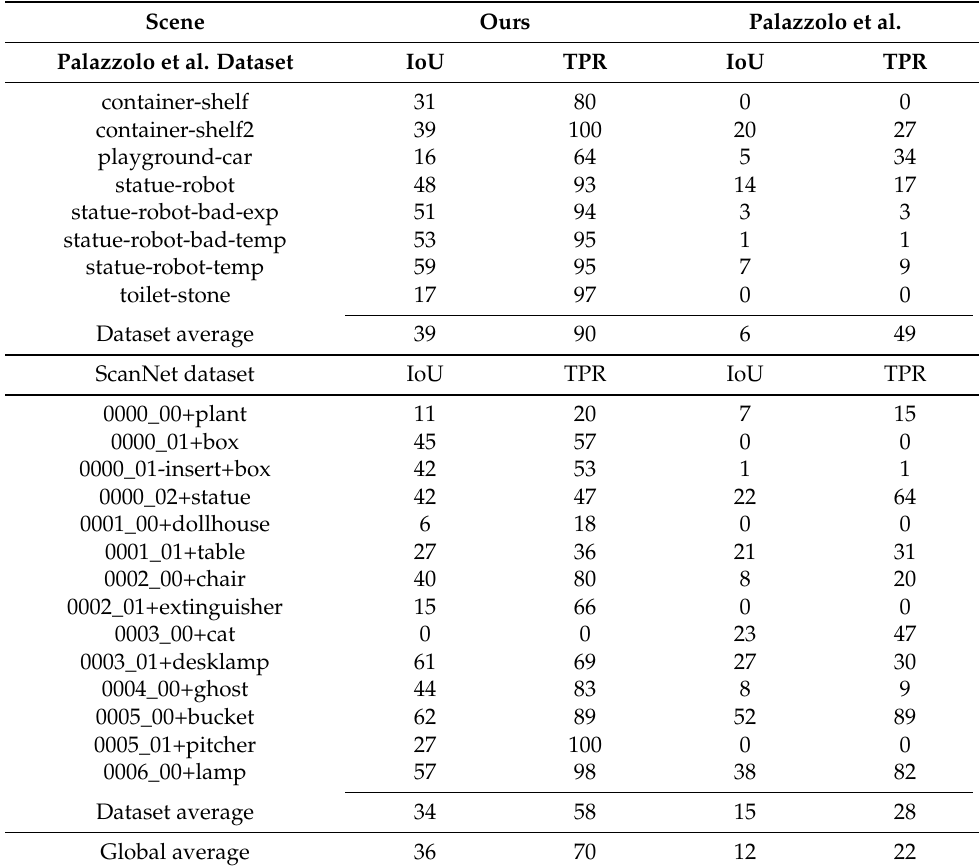
Table 1. Removal detection: quantitative results (in